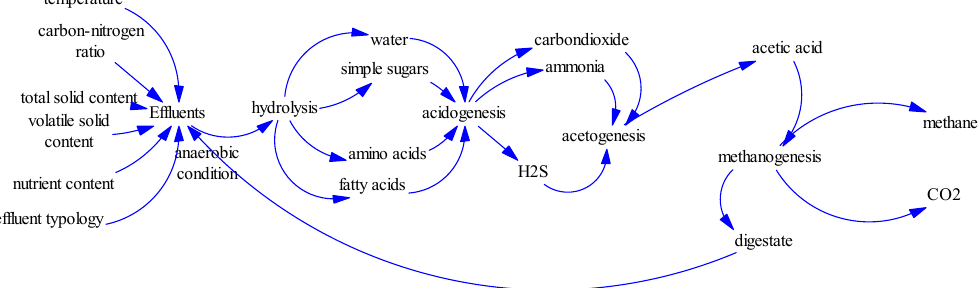
Figure 2. Adapted causal diagram of the anaerobic digestion of effluents used for biogas production [30]. Figure 3 is the adapted CLD [30] for energy recovery potential from the biogas pro- duced from the effluents generated in the processes of the three F&Bi types.